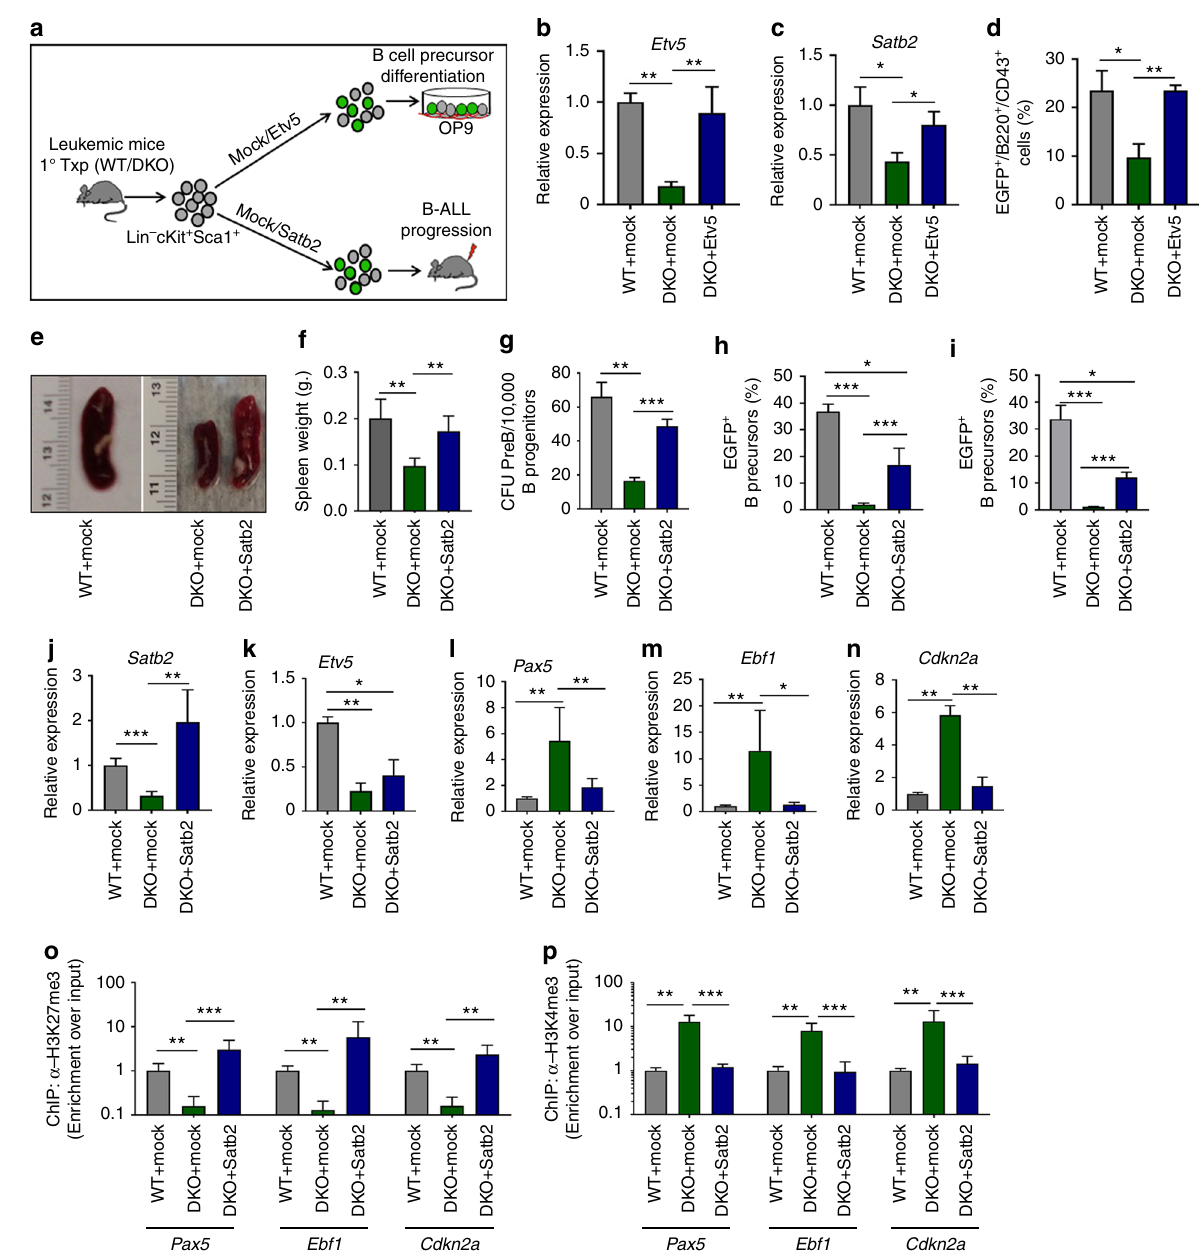
Fig. 5 Forced expression of Etv5 and Satb2 rescue B cell differentiation arrest. a Schematic diagram of Etv5 and Satb2 ectopic expression in Lin − cKit + Sca1 + (LSK) cells derived from Scl/p210 primary chimeric mice and co-culture on a OP9 mouse stromal cells monolayer and/or in vivo transplantation into secondary recipients. b Q-RT PCR showing expression of Etv5 in mock/Etv5 transduced B progenitors. c Q-RT PCR analyses showing rescue of Satb2 expression in Etv5 transduced B progenitors. d FACS quanti fi cation of EGFP + (mock/Etv5/Satb2 expressing) B-cell progenitors derived from OP9